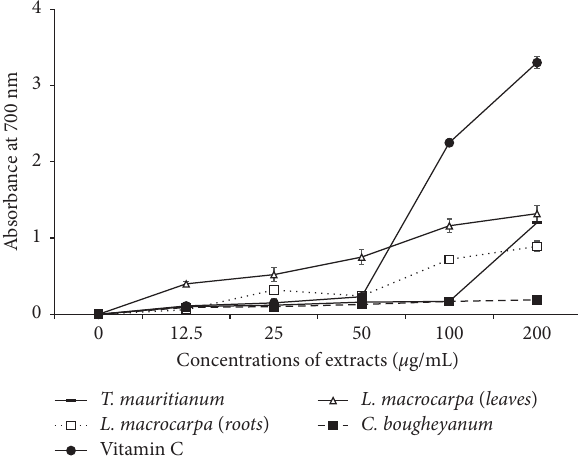
Figure 2: Ferric reduction ability of plant extracts as a function of concentrations. Table 4: Hydroxyl-radical scavenging activity of plant extracts as a function of concentrations. Plant